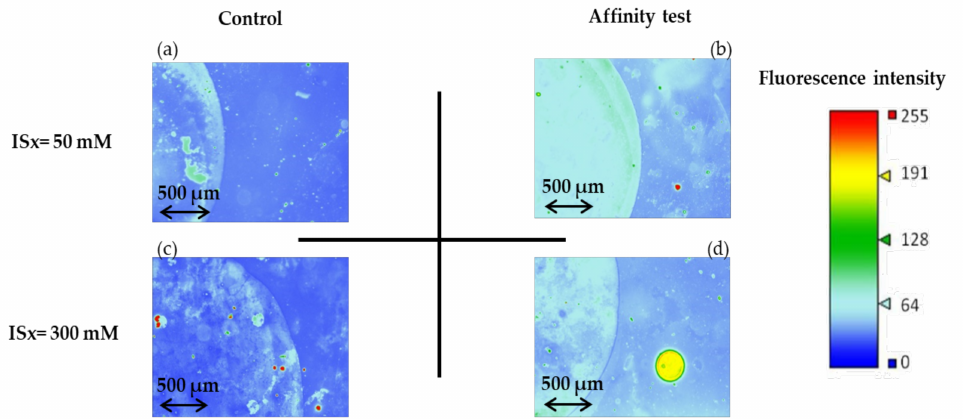
Figure 9. Fluorescence images (recorded as false color) of the microchannels after the a ffi nity test for sulforhodamine B and after rinsing (See experimental section for more details on experimental conditions and fluorescence measurement parameters). ( a , b ) are the fluorescence images recorded for experiences carry out with the phosphate sodium bu ff er with ISx = 50 mM, for the control and a ffi nity test, respectively, and ( c , d ) are the fluorescence images recorded for the experiences to carry out the phosphate sodium bu ff er at ISx = 300